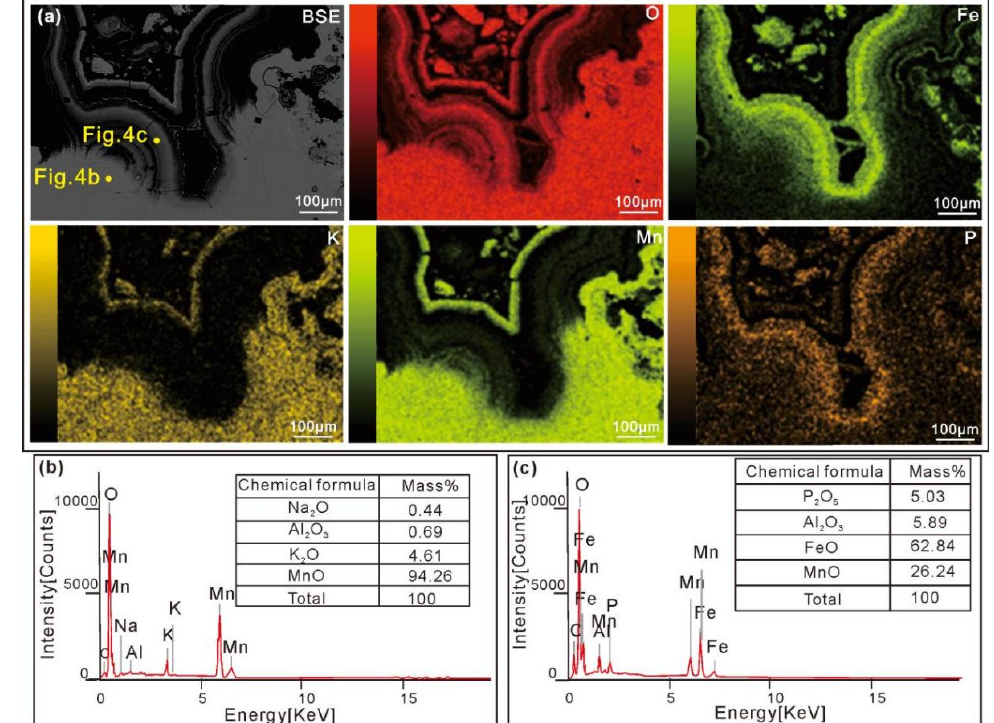
Figure 4. EDS Mapping of Mn oxide minerals in the Xiangtan deposit. ( a ) BSE image reveals the complexity of the microstructure and EDS Mapping showing the elemental distribution of O, Fe, K, Mn and P; ( b , c ) are the EDS results (analyzed points shown in ( a ) correspondingly).